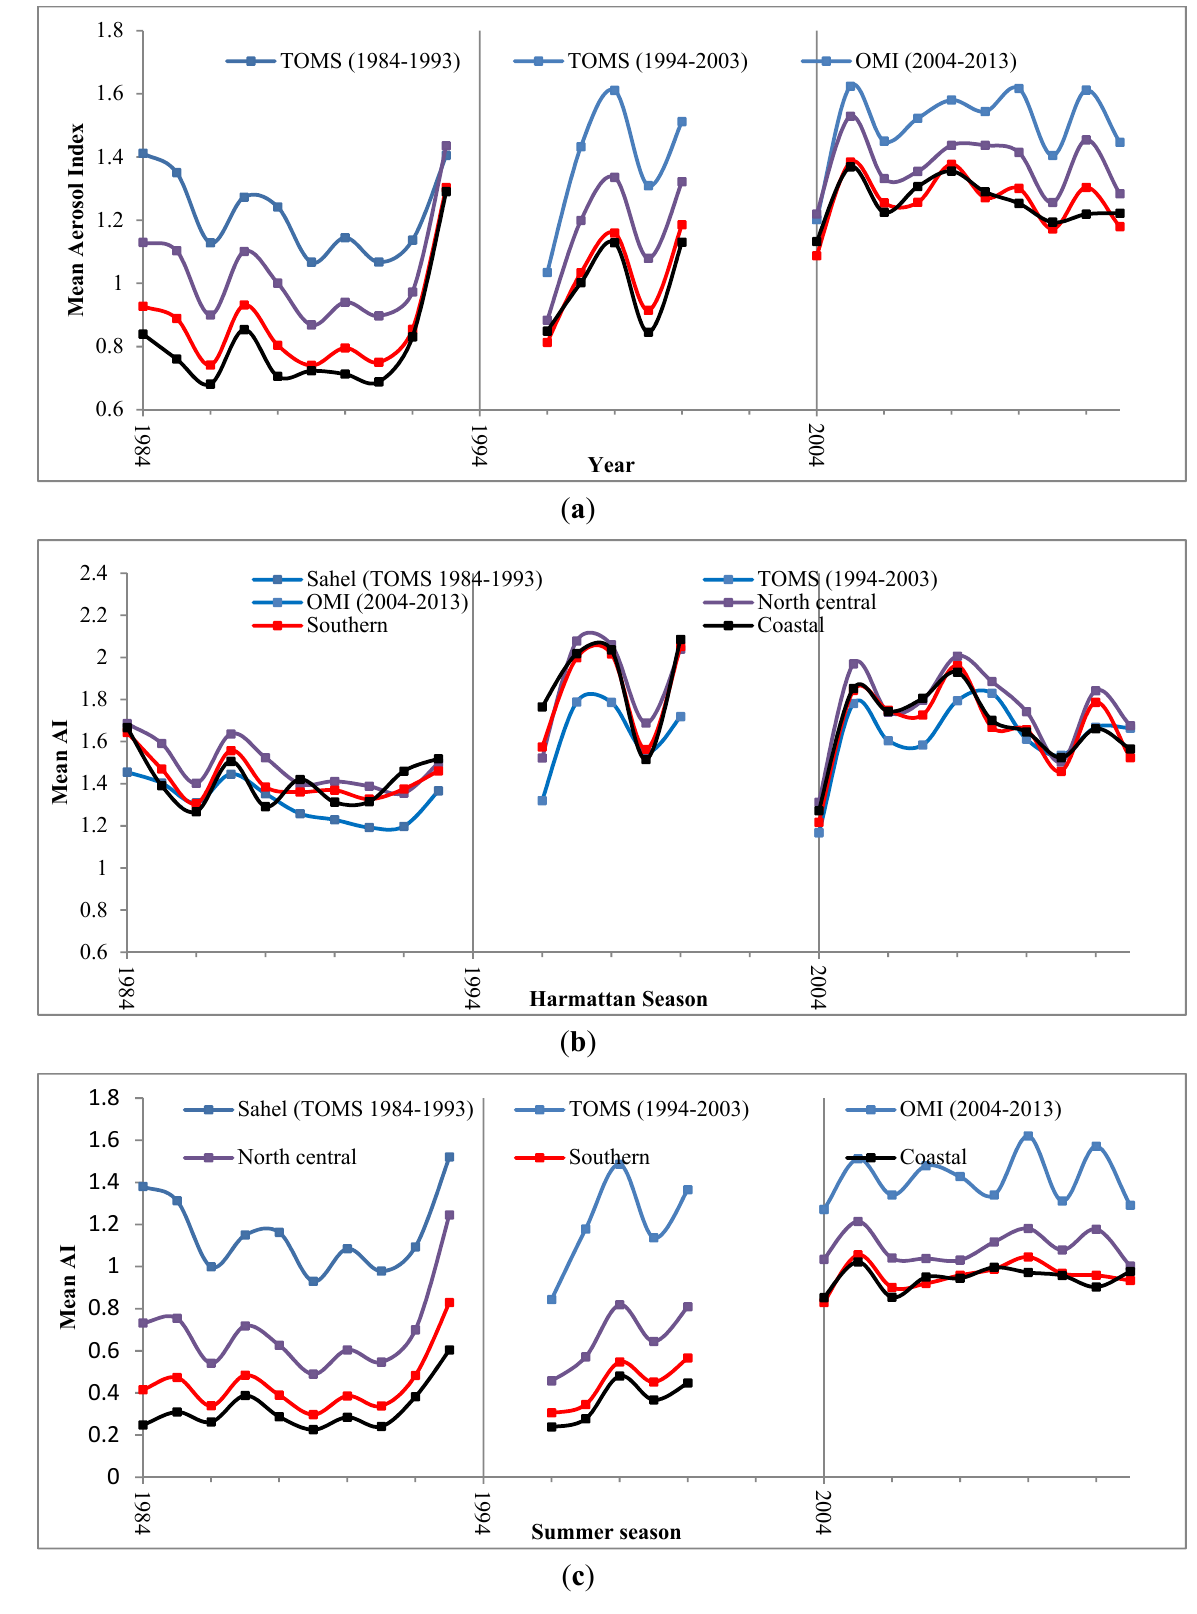
Figure 3. The 30-years annual mean, Harmattan and Summer AI trend over Nigerian zones at four climatic zones of Nigeria. ( a ) Annual mean, ( b ) Harmattan, ( c )